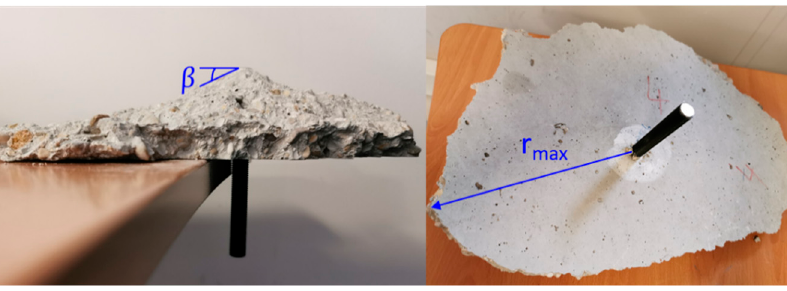
( b ) Figure 12. Load–displacement curves for: ( a ) h ef = 75 mm and ( b ) h ef = 125 mm. For the 75 mm anchors, which all experienced concrete cone failure, the load–dis- placement curves show a first linear phase more or less overlapping for all the tests, whether at room or high temperature. Then, at high temperature, this phase is followed by a second non-linear phase, where the slope of the load–displacement curve decreases. The behaviors of the two anchors were different in this non-linear phase, resulting in dif- ferent displacements despite quite similar peak loads. For the 125 mm anchors, which failed by combined failure, a first linear phase can also be seen in the load–displacement curves, where the curves are more or less superim- posed for the tests at ambient temperature, except for 125-1. At high temperature, the curves have a less steep slope from the beginning of the tests, showing a more ductile